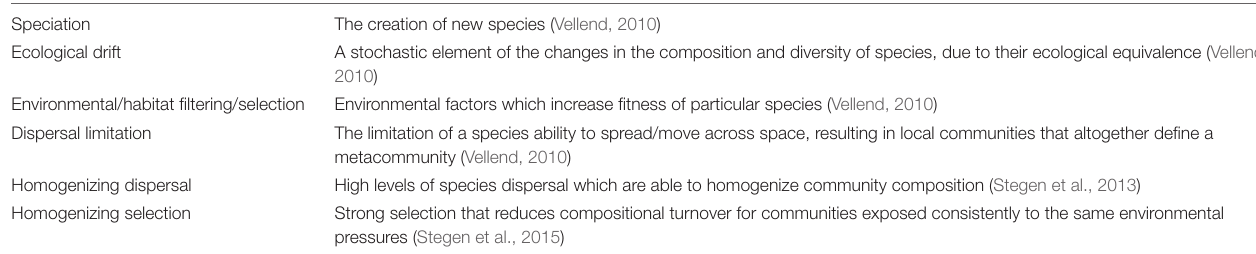
TABLE 2 | Glossary of ecological